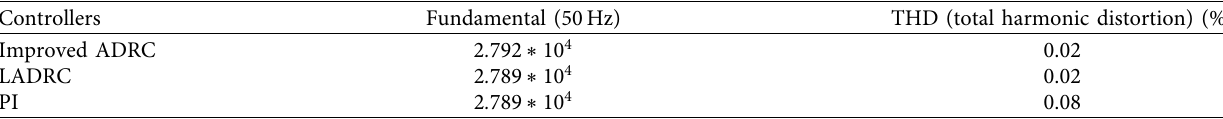
Table 3: Harmonic analysis comparison of phase A voltage.